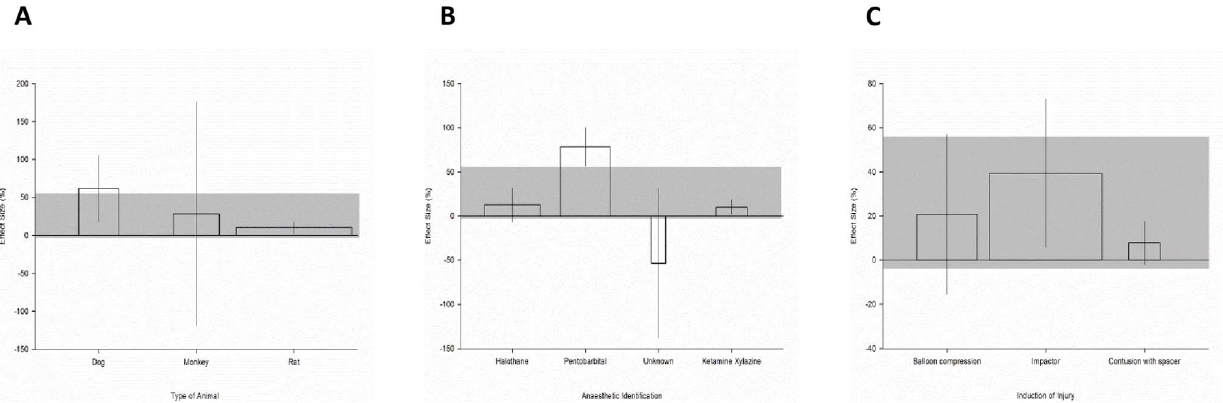
Figure 6. Model specific parameters of regional hypothermia experiments. Effect of ( A ) animal species, ( B ) anaesthetic, and ( C ) induction of injury used, on the effect size observed within experiments utilising regional hypothermia. The shaded gray bar represents the 95% confidence limits of the global estimate. The vertical error bars represent the 95% confidence intervals for the individual estimates. The width of each bar reflects the log of the number of animals contributing to that comparison. Each stratification accounts for a significant proportion of the heterogeneity observed between studies.